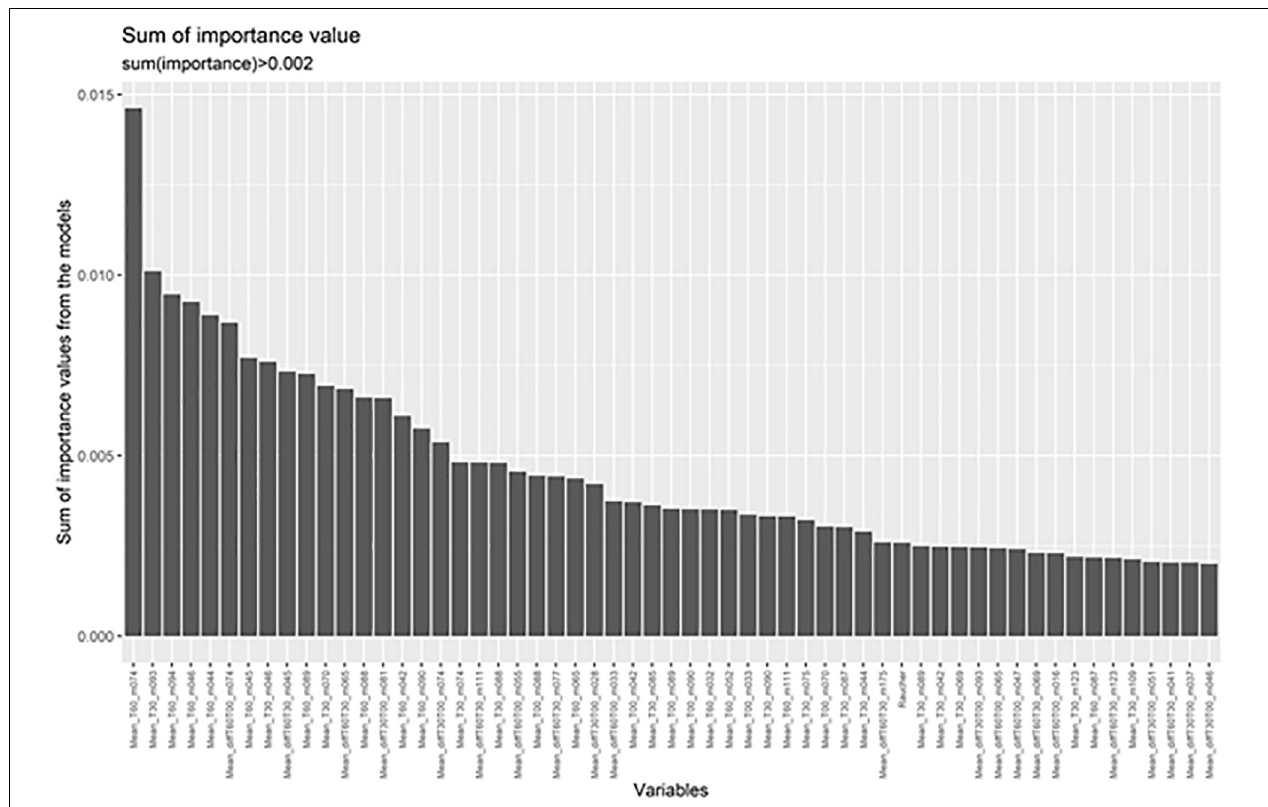
FIGURE 2 | Random forest analyses indicate the masses most important for differentiating between patients and controls. These are shown in order of